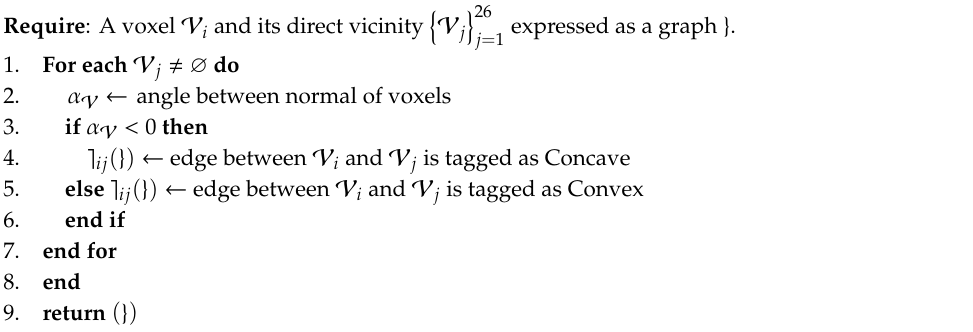
Algorithm 1. Voxel Relation Convexity / Concavity